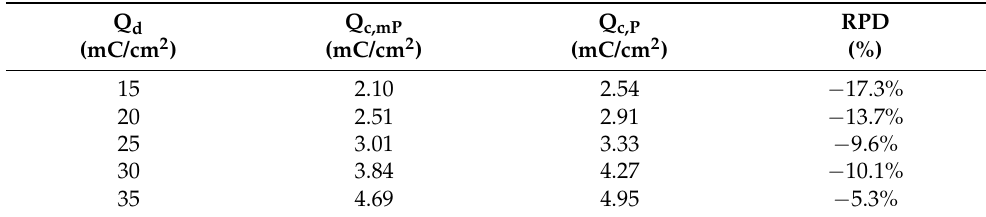
Table 2. Coloration charge capacities of the mPEDOT and PEDOT thin films prepared using different Q d